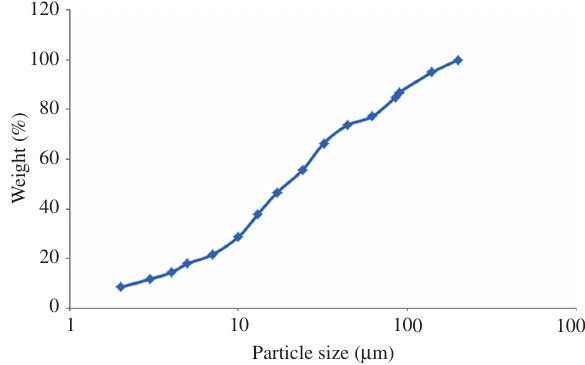
Table 1 Chemical composition of Hasankale ground pumice.